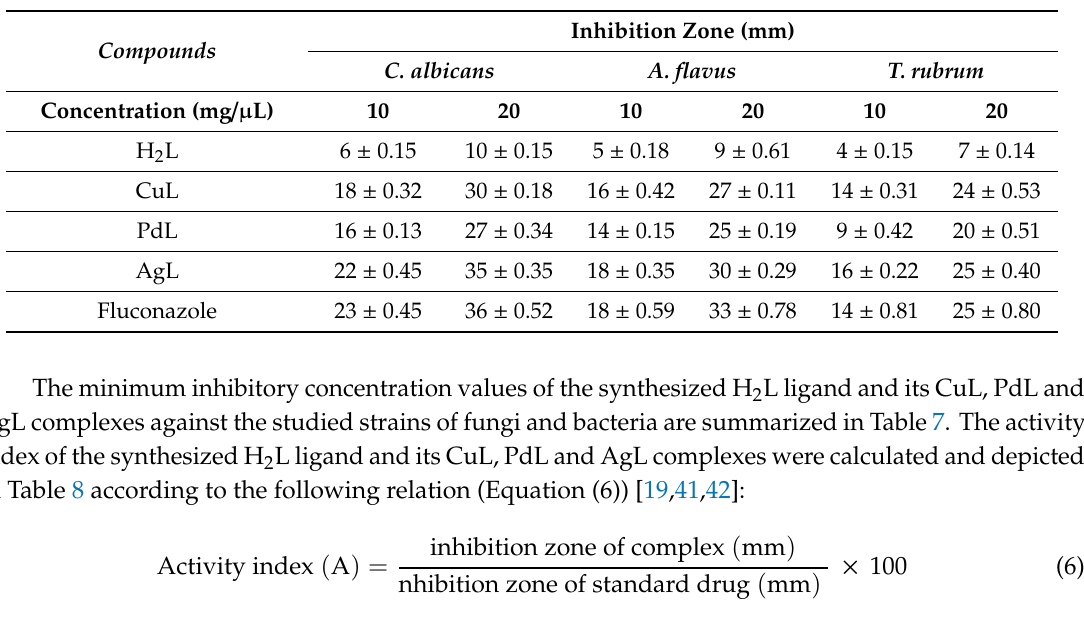
Table 6. Antifungal bioassay results of the prepared compounds against studied strains of fungi compared to